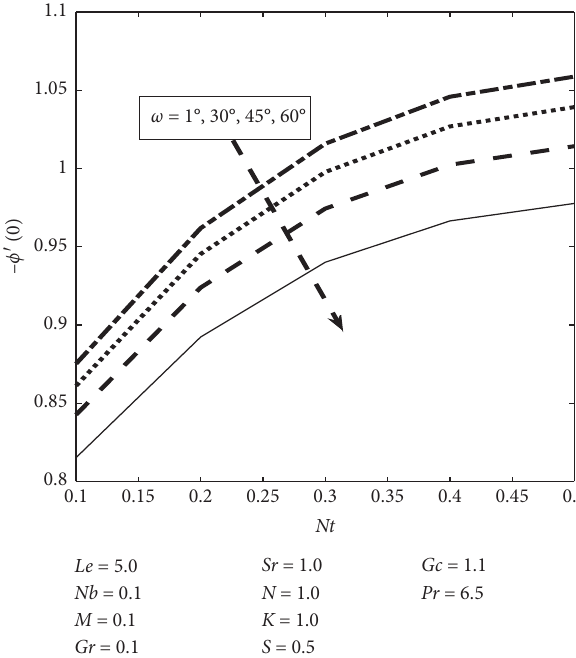
Figure 23: Variations of reduced Sherwood number with Nt for different values of ω .